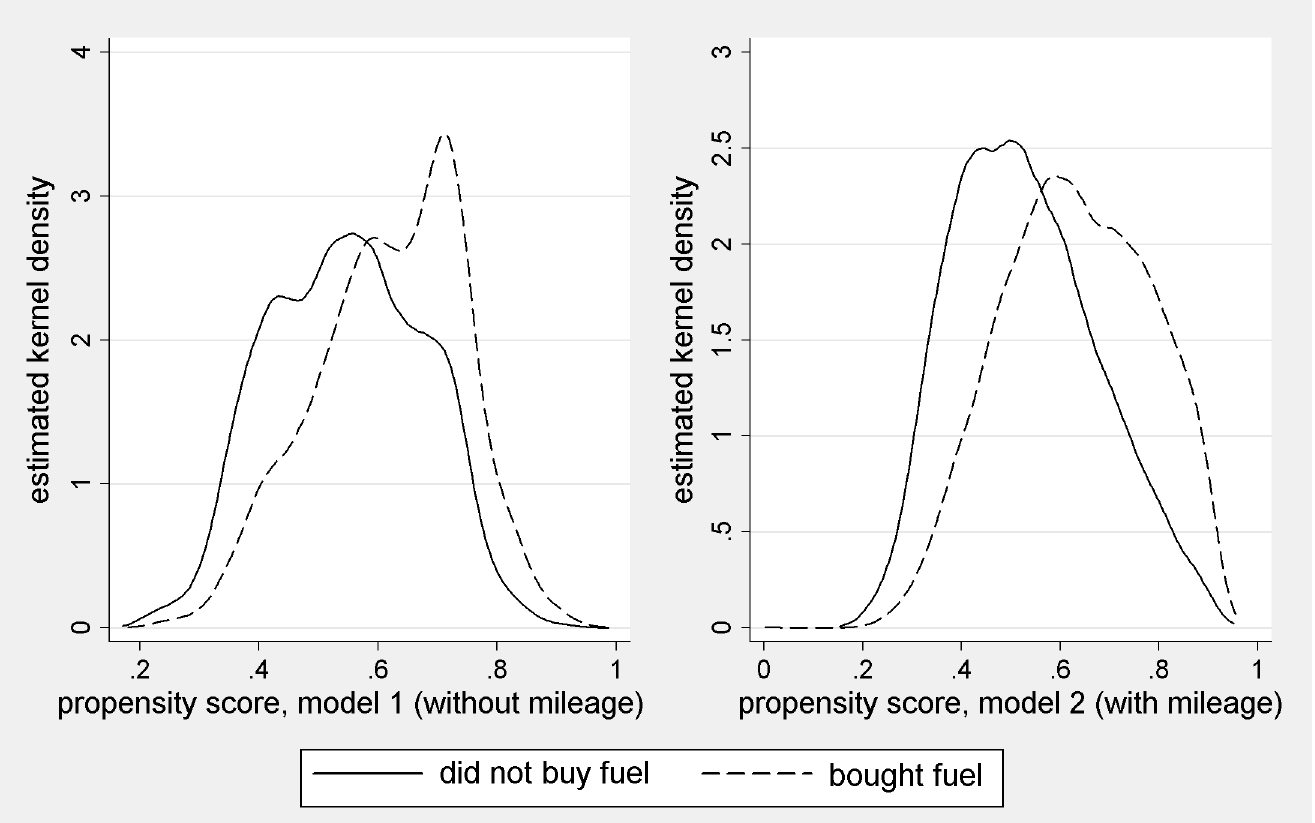
Fig 3. Estimated propensity scores: kernel density estimates. Note: Epanechnikov